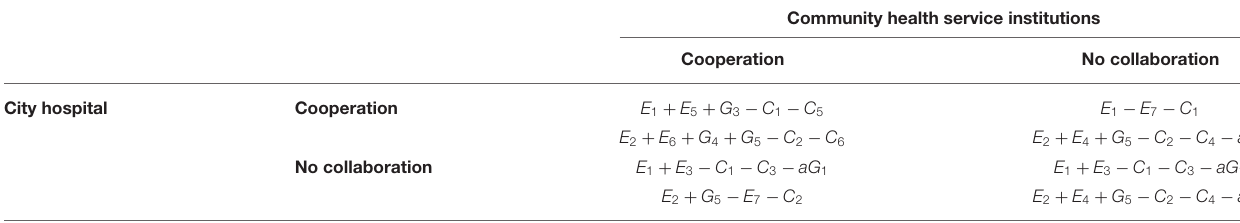
TABLE 1 | Payment matrix of cooperation strategy selection game between urban hospitals and community health service